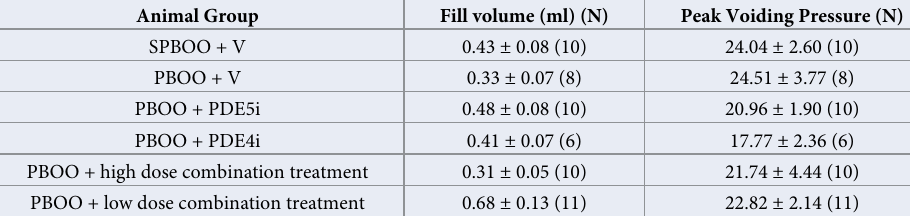
Table 2. Additional outcomes of anesthetized cystometry. Animal